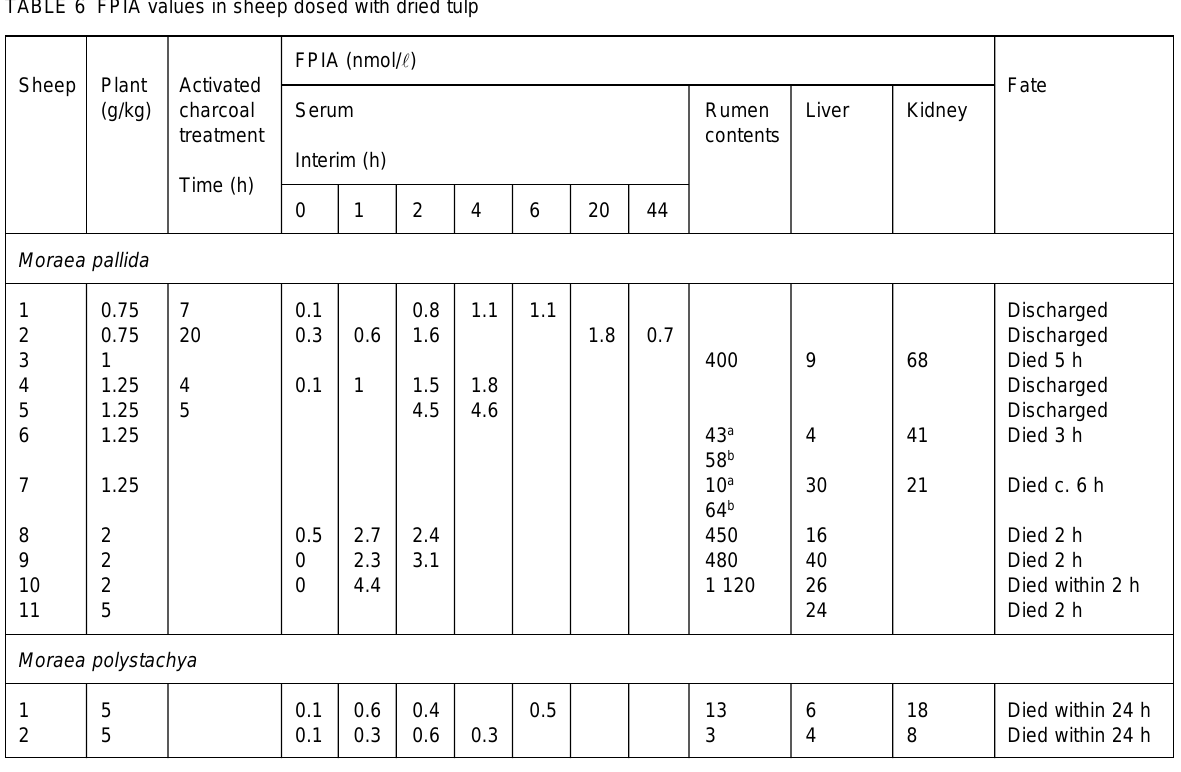
TABLE 6 FPIA values in sheep dosed with dried tulp